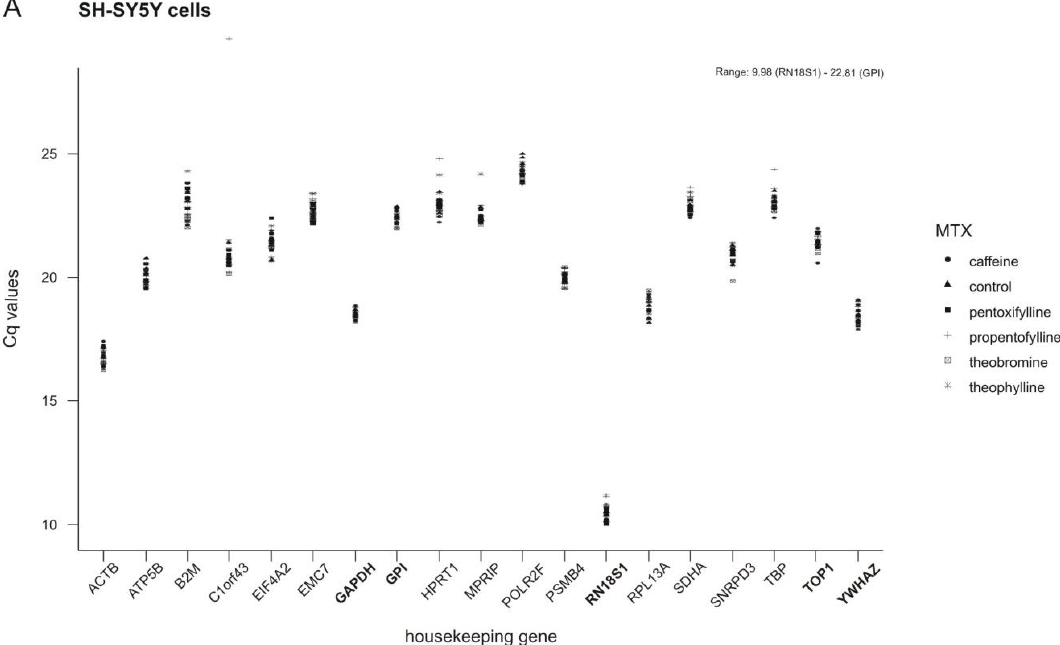
Figure 3. Selection of housekeeping genes (HKGs) for normalization in SH-SY5Y cells. ( A ) Expression levels of the selected putative HKGs given as quantitative real-time RT-PCR cycle threshold (Cq) values in SH-SY5Y cells after treatment with solvent control, caffeine, theophylline, pentoxifylline, theobromine or propentofylline. The five most stable HKGs are presented in bold letters. ( B ) Expression stability values for 19 analyzed genes calculated by the NormFinder algorithm. Classification of stability values in most stable genes (0 < stability value < 0.37; green), intermediate genes (0.37 < stability value < 0.53; yellow) and least stable genes (0.53 < stability value < 0.69; red) was done in accordance with Penna et al. [25]. HKGs are ranked from the least to the most stable from left to right and the five most stable genes selected for normalization in SH-SY5Y cells ( RN18S1 , GPI , TOP1 , YWHAZ and GAPDH ) are highlighted by a box.